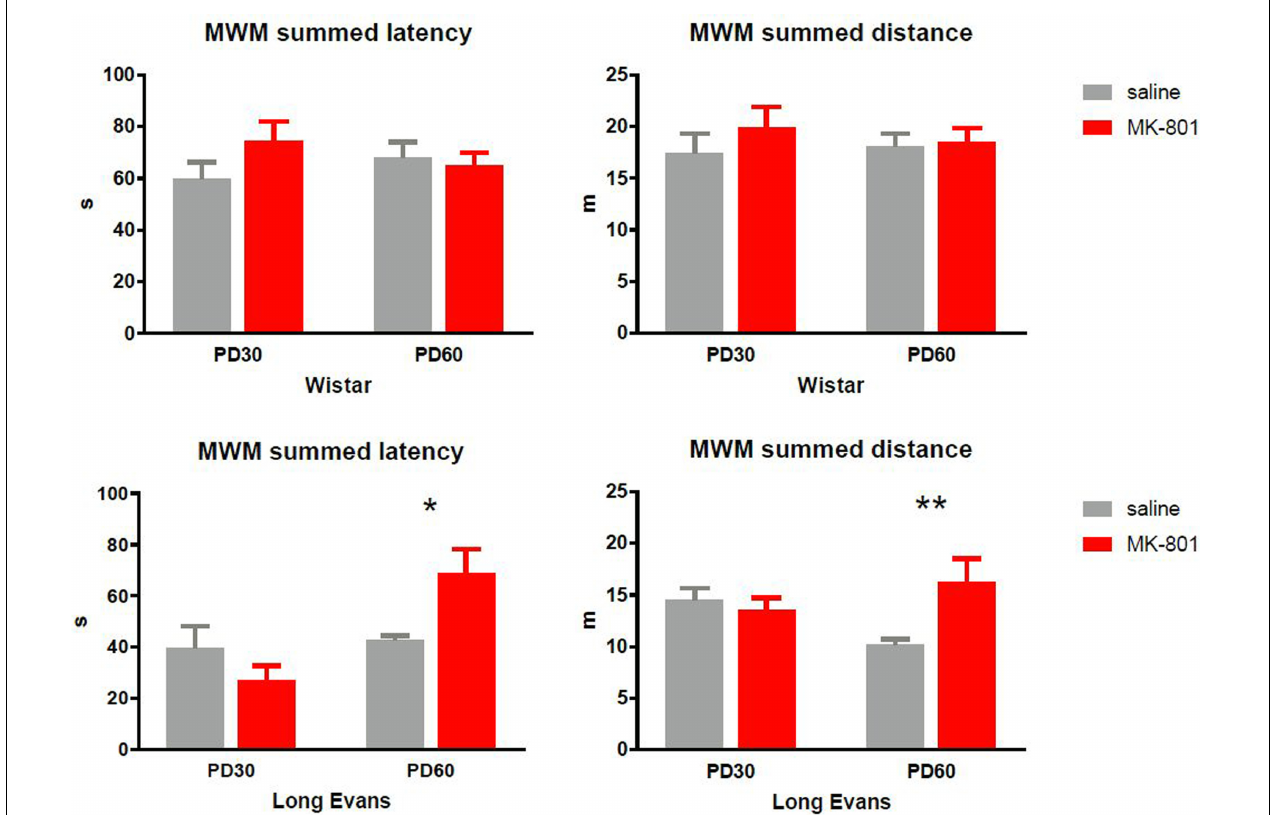
FIGURE 3 | Latency and path to the platform (distance) in the water maze summed for swim 2, 3, and 4, and averaged across the 10 days of training. In the Long-Evans PD 60 cohort, MK-801 treated rats did not search for the platform on repeated swims as efficiently as saline treated rats ( ∗ P < 0.05, ∗∗ P < 0.01). Group means ±